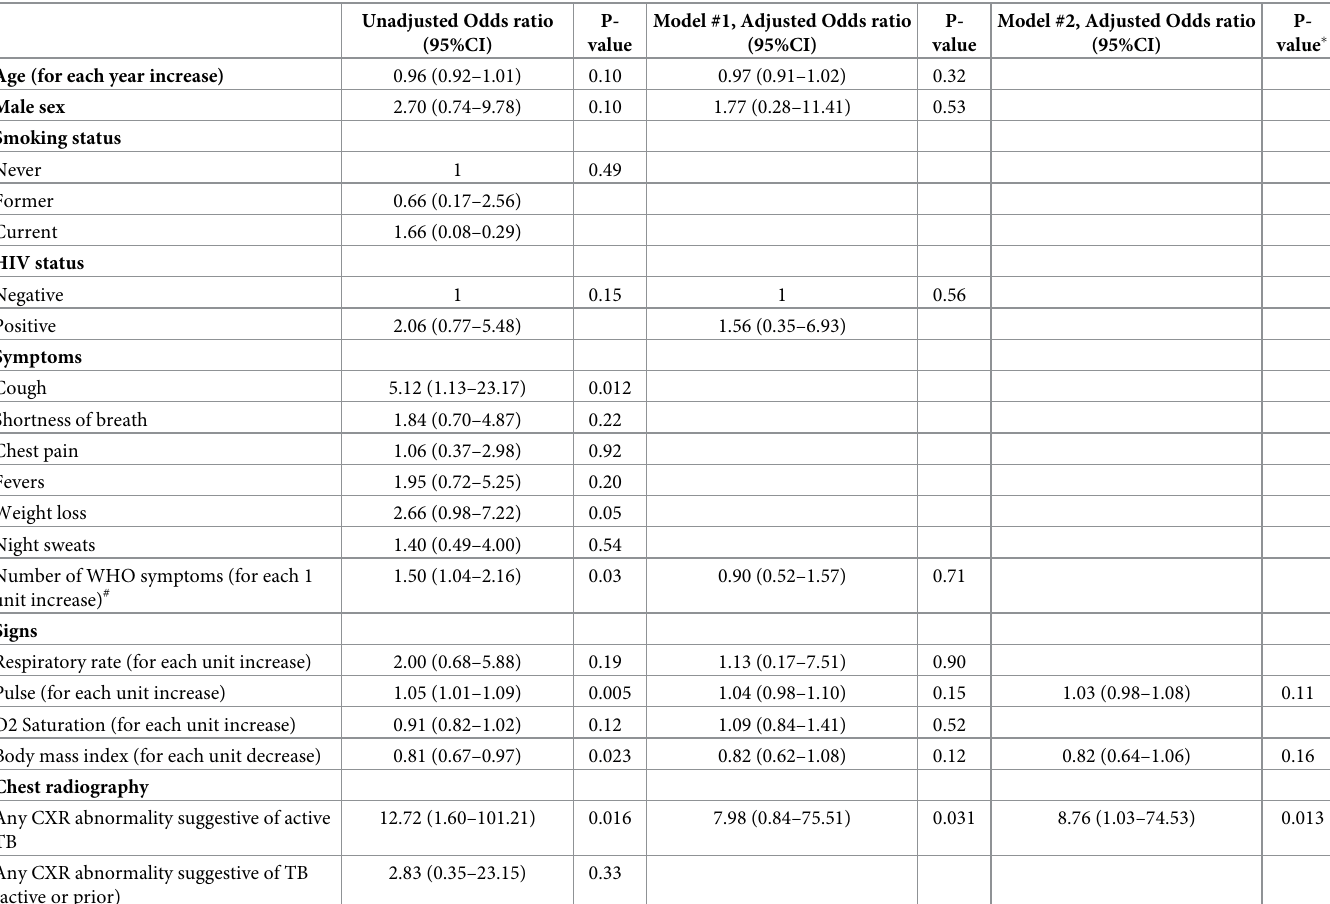
Table 3. Unadjusted and adjusted odds ratio for active tuberculosis among previously treated, presumptive TB patients (n = 100). Unadjusted Odds ratio